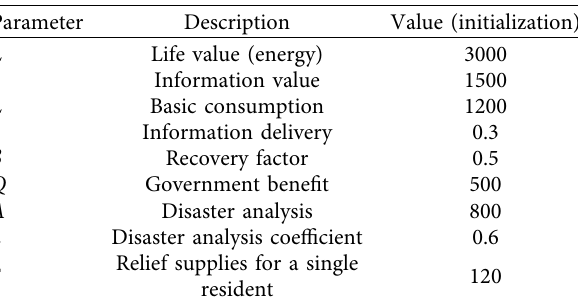
Figure 3: Running display of rainstorm disaster simulation using Repast. Table 2: Parameter setting